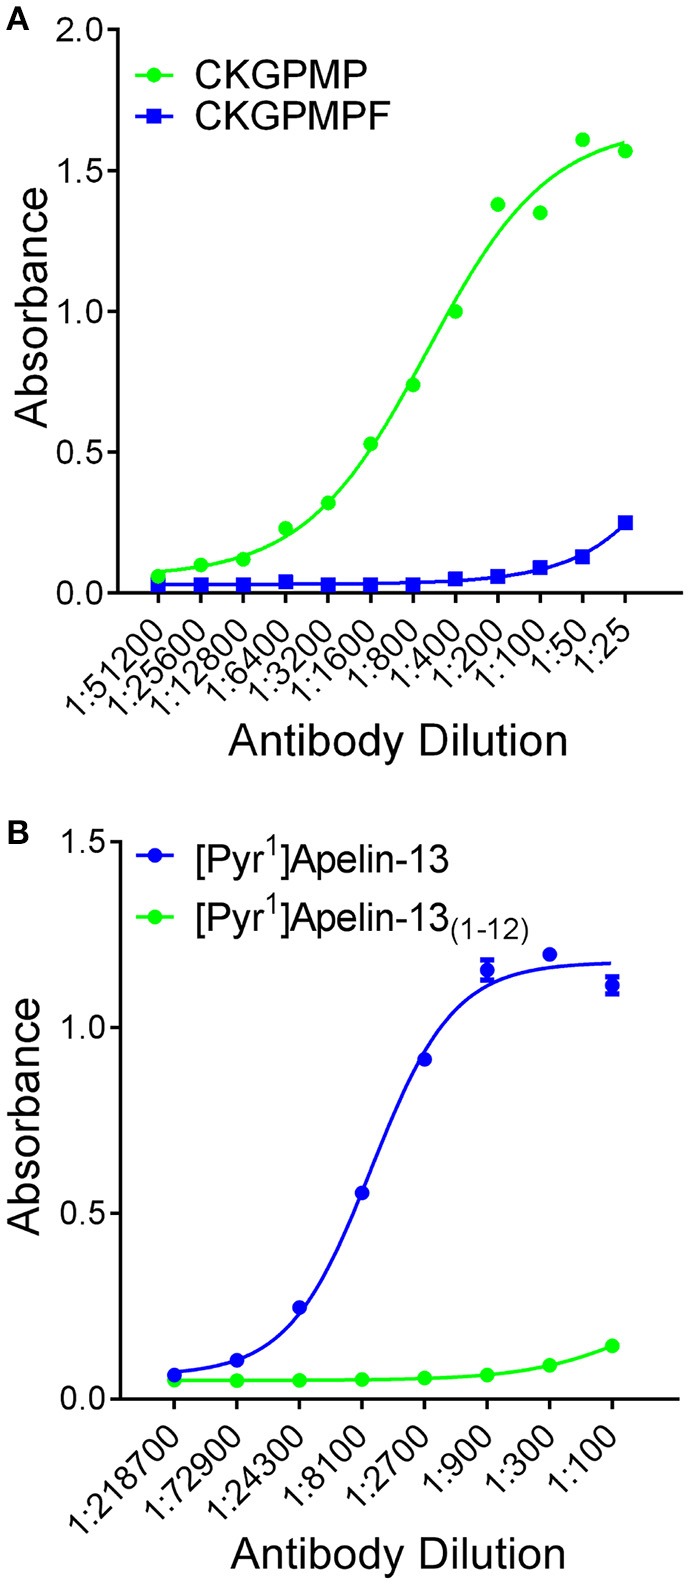
Selectivity of antisera determined by ELISA. (A) [Pyr1]apelin-13(1–12) antiserum demonstrated selectivity to the antigen CKGPMP (, corresponding to [Pyr1]Apelin-13(1–12)) relative to CKGPMPF (, corresponding to [Pyr1]Apelin-13). (B) The apelin-12 antiserum demonstrated selectivity to [Pyr1]Apelin-13 () relative to [Pyr1]Apelin-13(1–12) ().